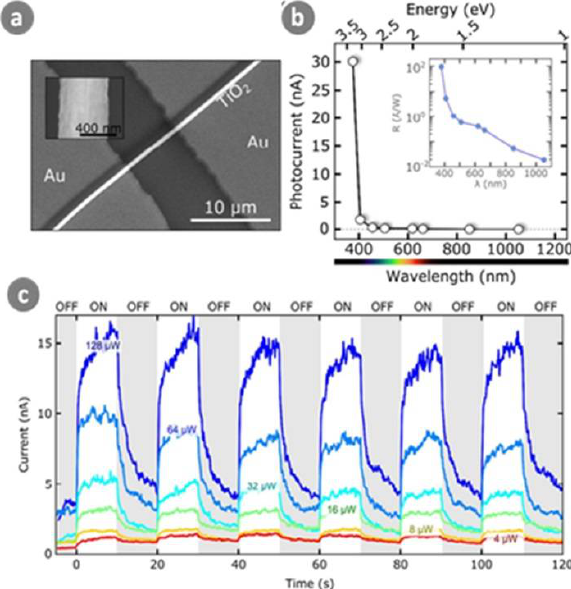
Figure 10. ( a ) SEM image a TiO 2 fiber photodetector. Inset: zoom of the fiber; ( b ) Photocurrent of the device shown in ( a ) as a function of the LED wavelength ( P = 2 µW, V b = 10 V). Inset: responsivity as a function of the LED wavelength; ( c ) Time response of the photodetector. In order to highlight the photocurrent, the dark current has been set to 0. The measured rise time is ~2.5 s and the fall time is